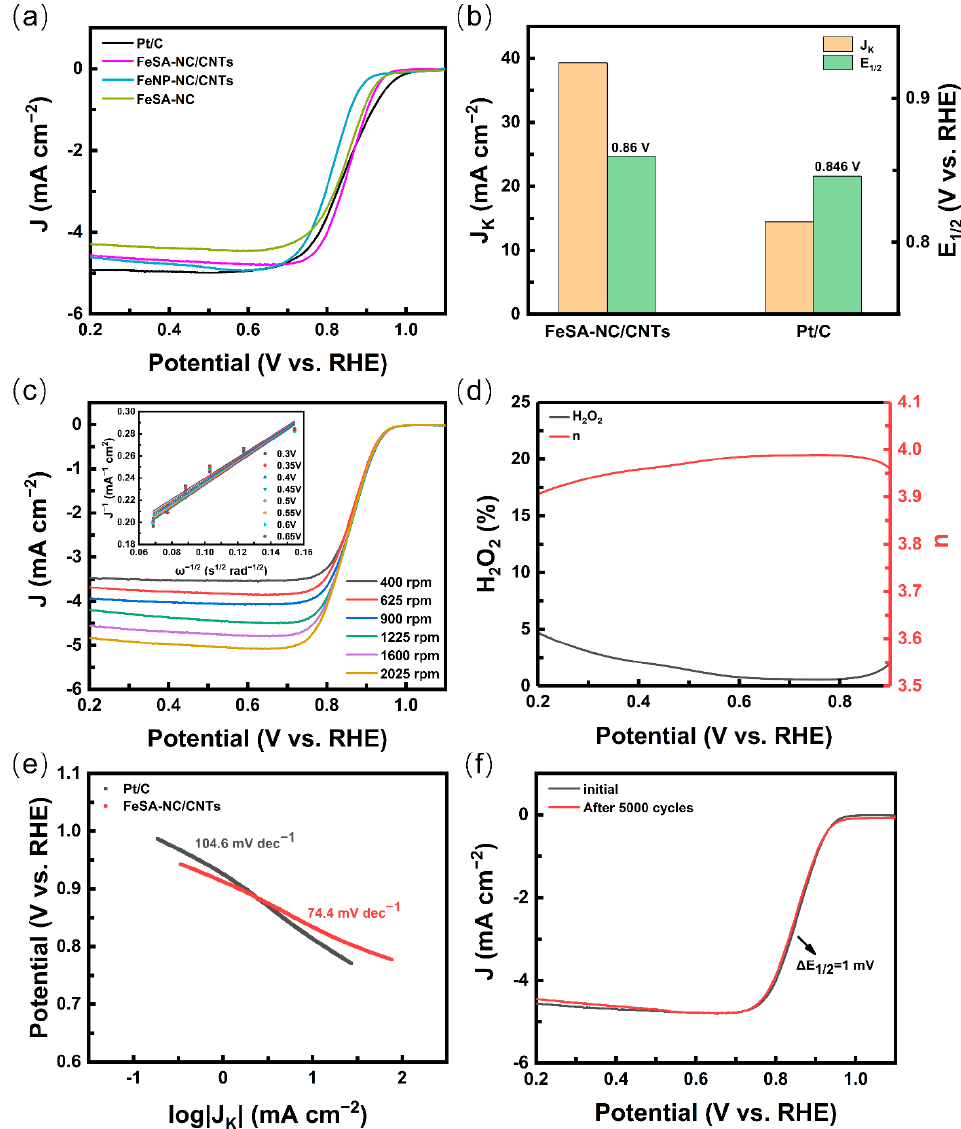
Figure 5. ( a ) ORR polarization plots of FeSA-NC/CNTs and Pt/C in O 2 -saturated 0.1 M KOH with a sweep rate of 5 mV s − 1 and 1600 rpm. ( b ) E 1/2 and J K at 0.8 V for different catalysts. ( c ) LSV curves of FeSA-NC/CNTs with various rotation rates (inset: K–L plots). ( d ) Electron transfer number and H 2 O 2 yield in ORR on FeSA-NC/CNTs from the RRDE results. ( e ) Tafel plots of Pt/C and FeSA-NC/CNTs. ( f ) LSV curves of FeSA-NC/CNTs before and after 5000 potential cycles.